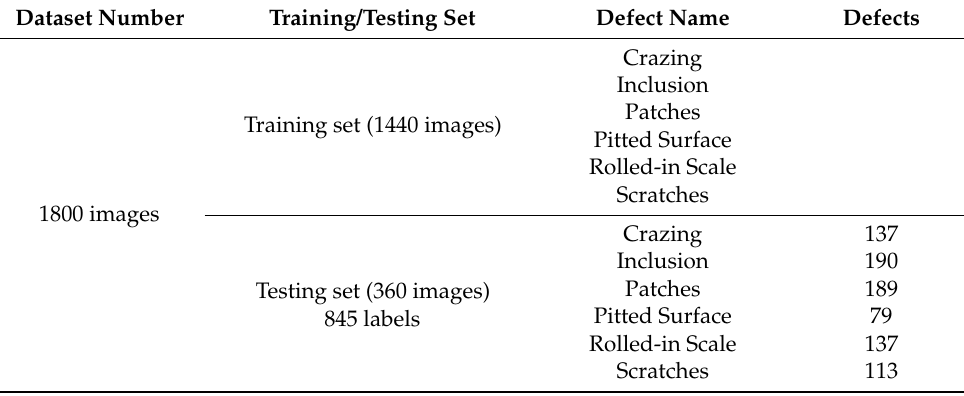
Table 2. Training/Testing Configuration.